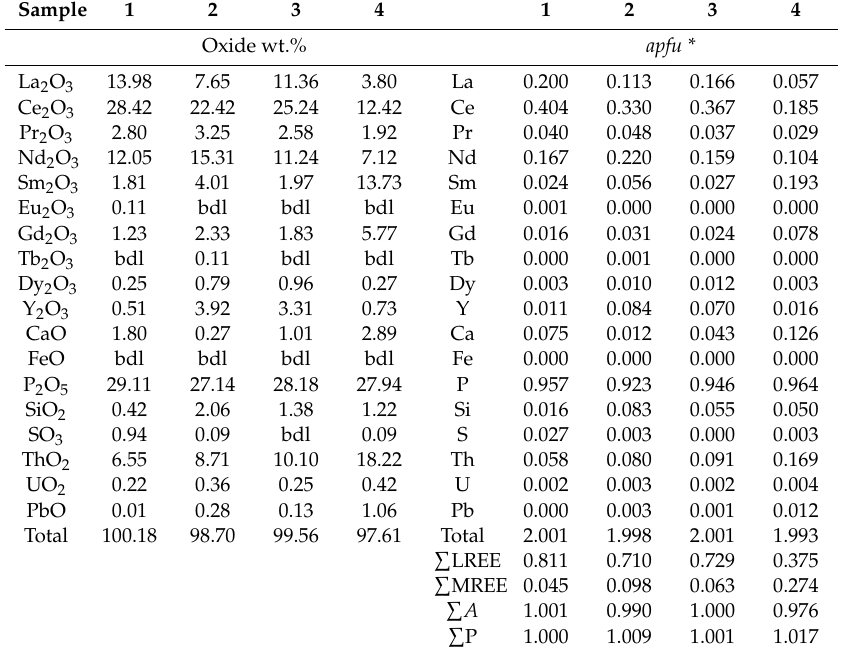
Table 2. Electron-probe microanalysis (EPMA) data for the four monazite samples examined in this